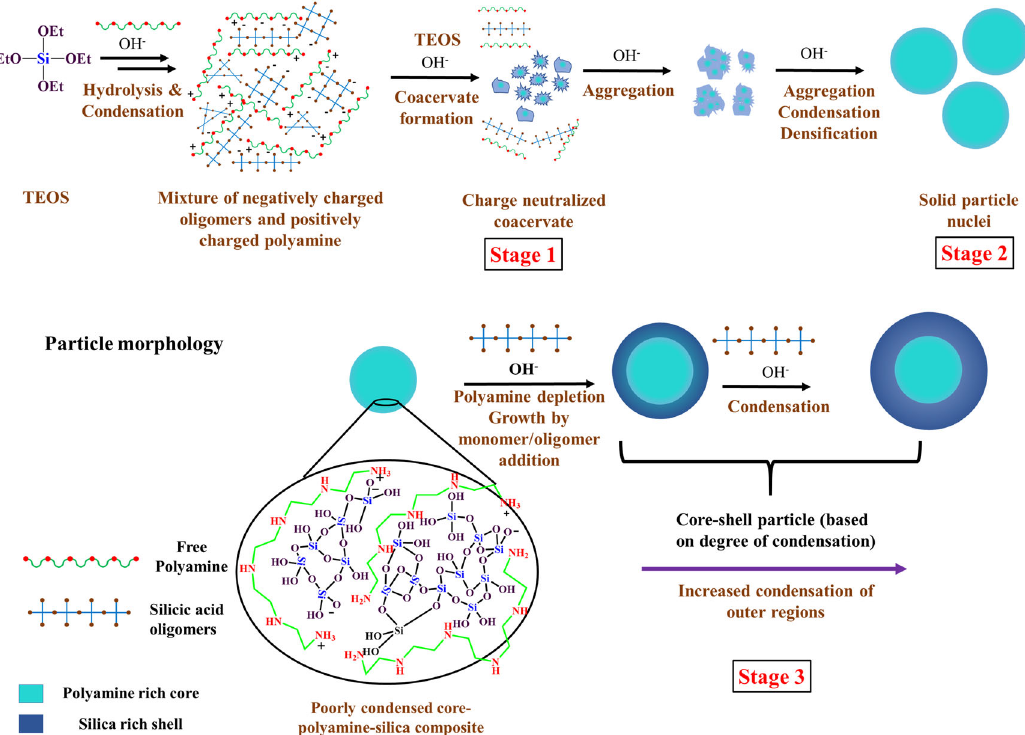
Fig. 7 Schematic representation of silica particle growth in the presence of polyamines. The core – shell particle re fl ects the different degrees of condensation in the particle (green colour represents polyamine